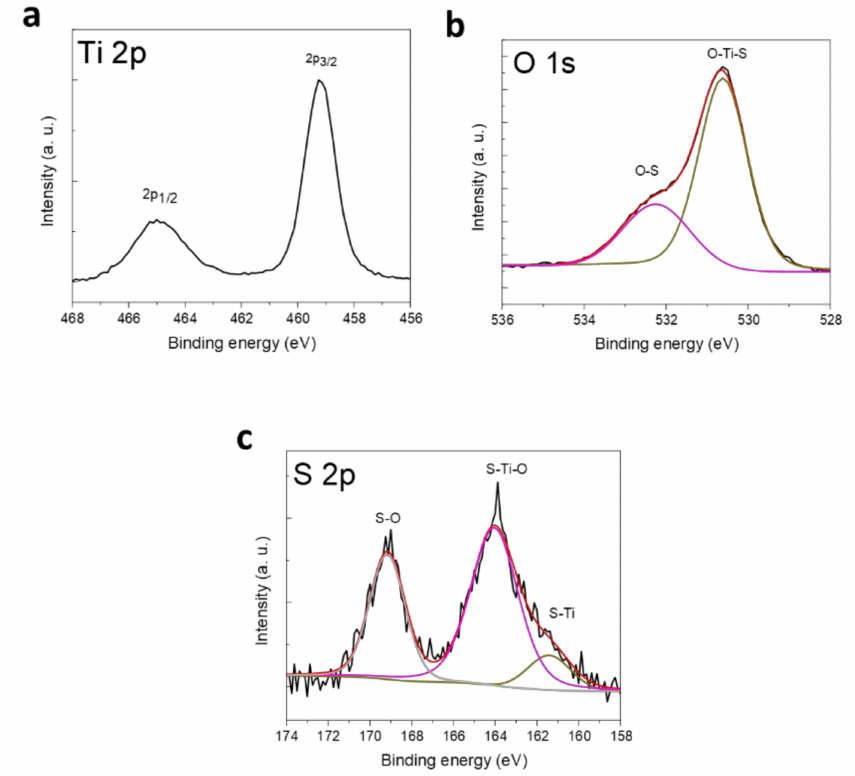
Figure 3. XP spectra for STNT samples ( a ) Ti 2p; ( b ) O 1s ( c ) S 2p. The black line corresponds to the measured spectra, the pink and yellow lines represent fitted data for each species, while the red line represents the whole calculated spectrum for O 1s and S